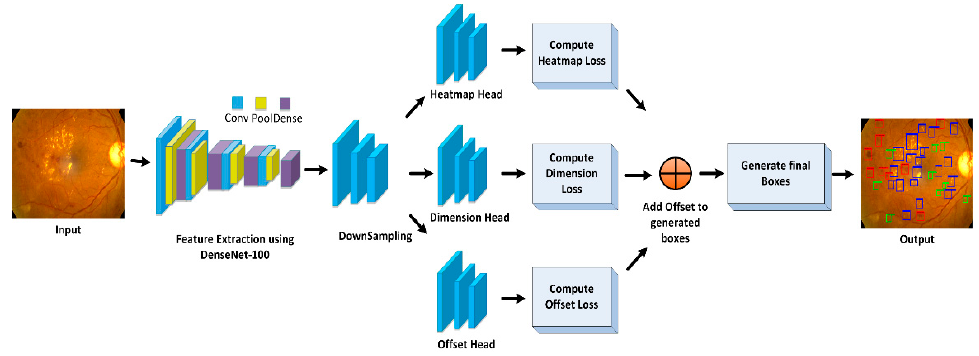
Figure 1. Flow diagram of proposed technique.